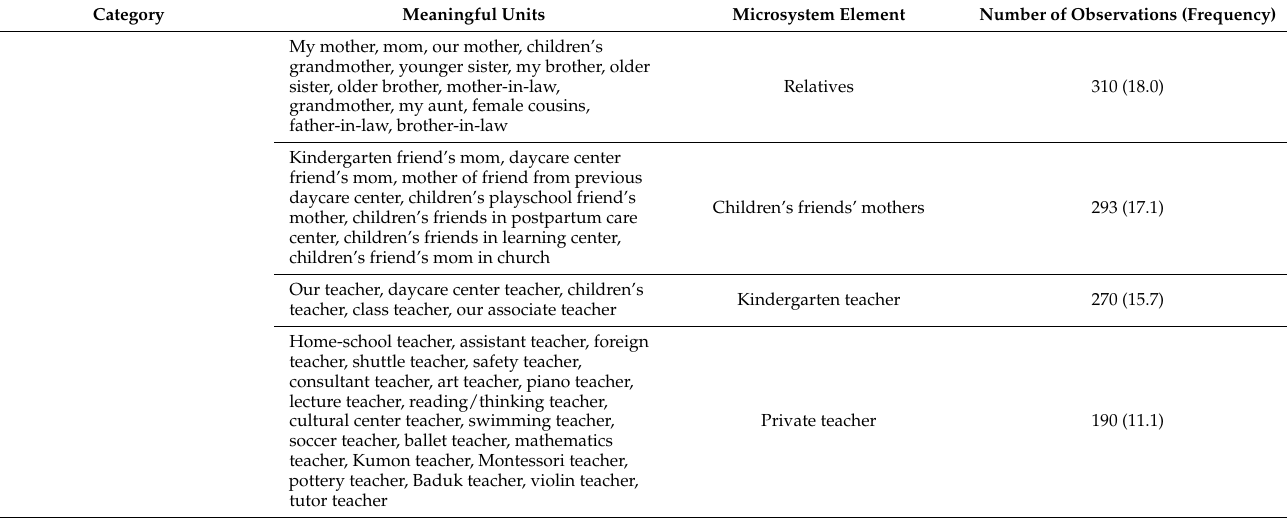
Table 2. Meaningful units, frequencies of occurrence, and ecological elements n = 1718